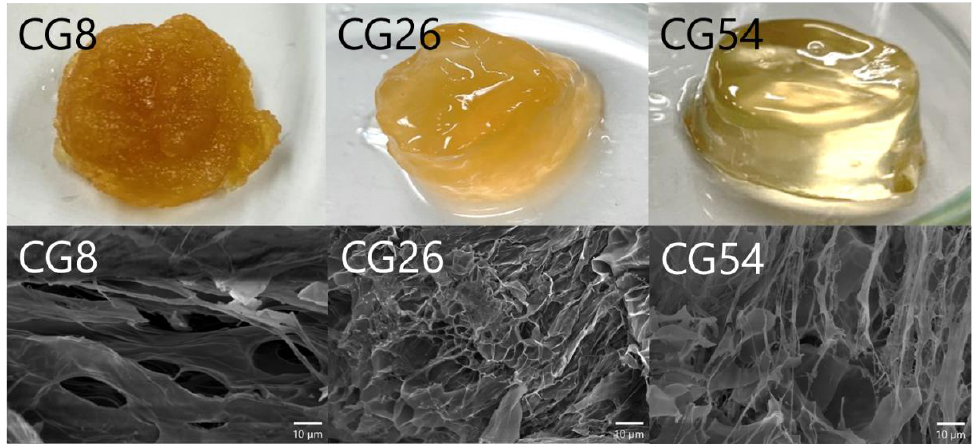
Figure 1. AC hydrogels prepared by autoclaving for 20 min (the hydrogels were prepared in a cylindrical vessel with a diameter of 15 mm) and scanning electron microscopic (SEM) images of their inner structure.